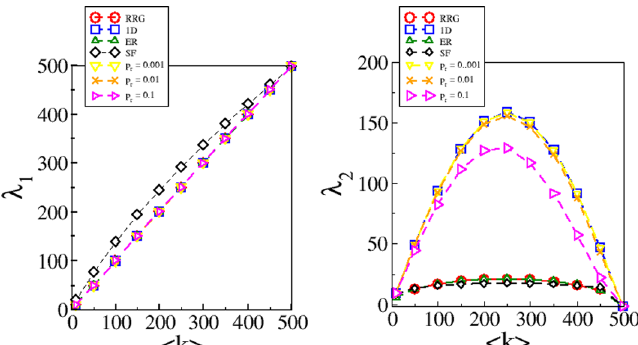
k 500 for 20 different with N (cid:31) (cid:30) =